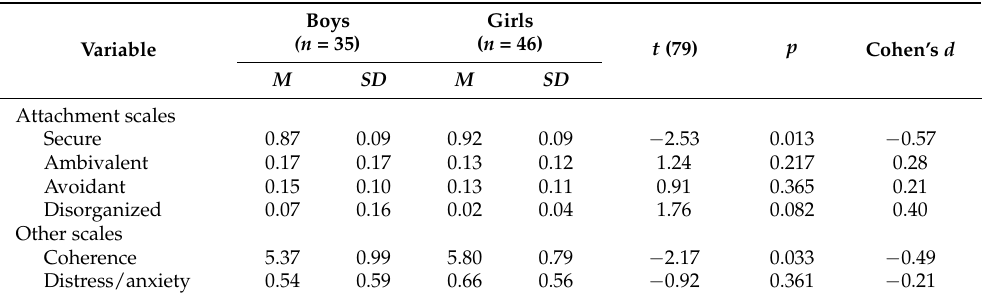
Table 6. Means, Standard Deviations, and t -test Statistics for the Scales comparing 8–10-year-old Boys and Girls in the Nonclinical Group.